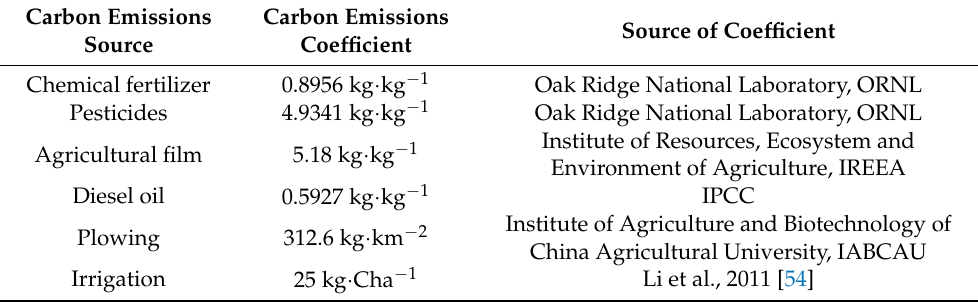
Table 1. Carbon emissions’ influencing factors and